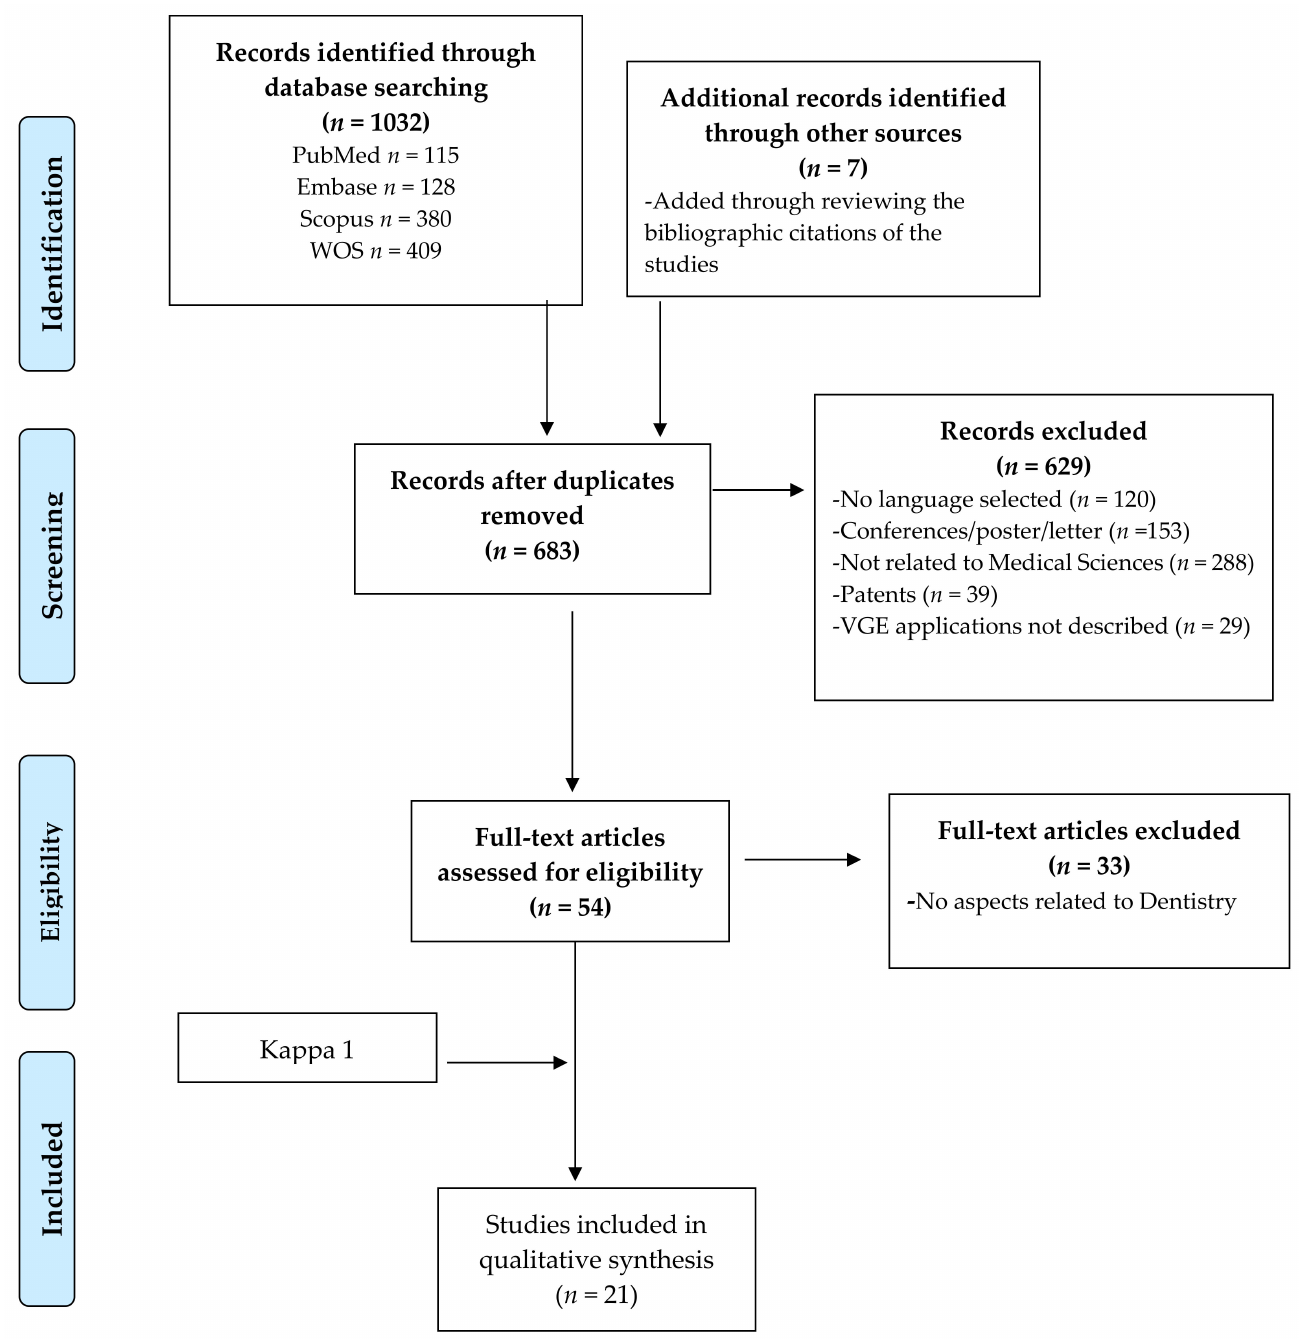
Figure 1. Flow diagram with the information through the phases of study selection based on PRISMA (Moher et al., 2009)